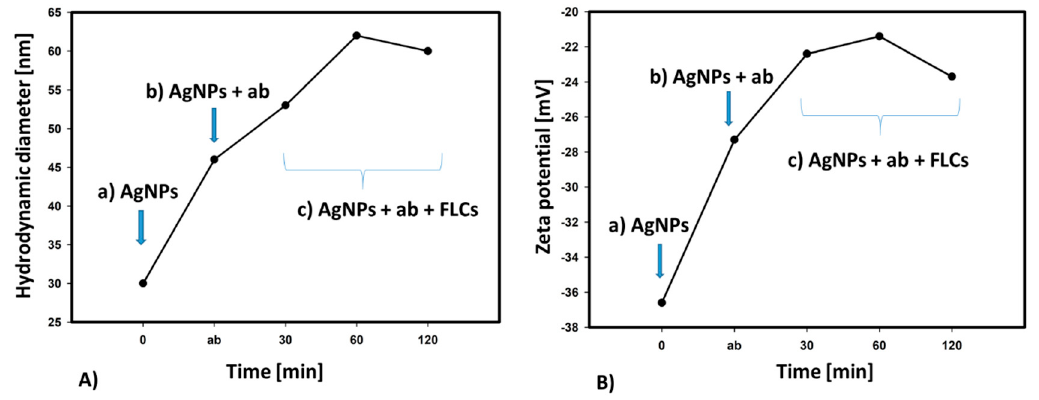
Figure 12. Changes in the hydrodynamic diameter ( A ) and zeta potential ( B ) of ( a ) the citrate-stabilized AgNPs (AgNPs), ( b ) antibody-functionalized AgNPs (AgNPs + ab) and ( c ) silver nanoparticles coated with antibodies, after the addition of FLCs (AgNPs + ab + FLCs).